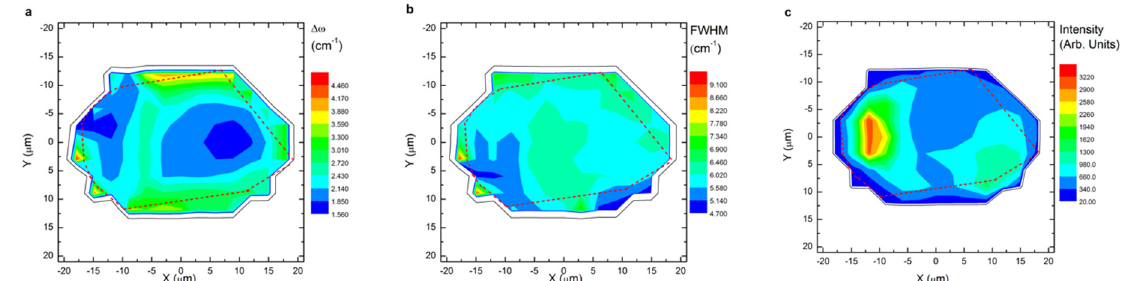
Figure 8. Raman maps of the Si inclusion. ( a ). ∆ ω = ω observed − ω unstrained Si. a value of 520.7 cm − 1 was used for the unstrained Si. ( b ). Full width at half maximum (FWHM) of the first order Si Raman mode. ( c ). Intensity of the first order Si Raman mode. The red dashed line outlines the surface expression of the Si inclusion.